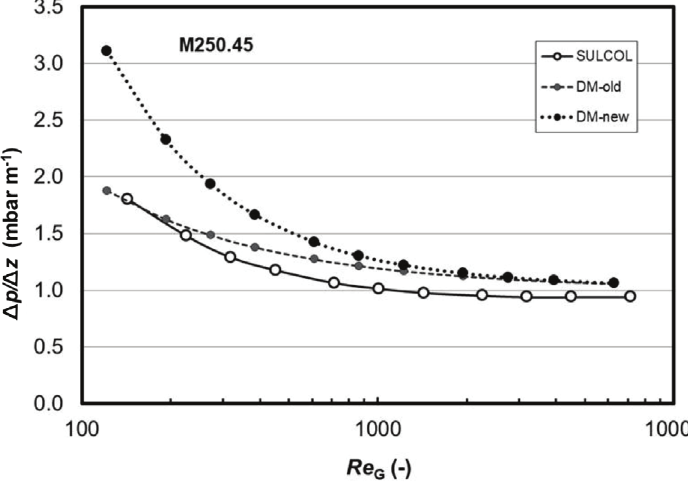
Fig. 8 – Specific pressure drop as estimated by original (DM-old) and extended DM (DM-new) for conventional corru- gated sheet structured packing (M250.45) in conjunction with given hypothetical base case, compared with SULCOL esti- mates for Mellapak